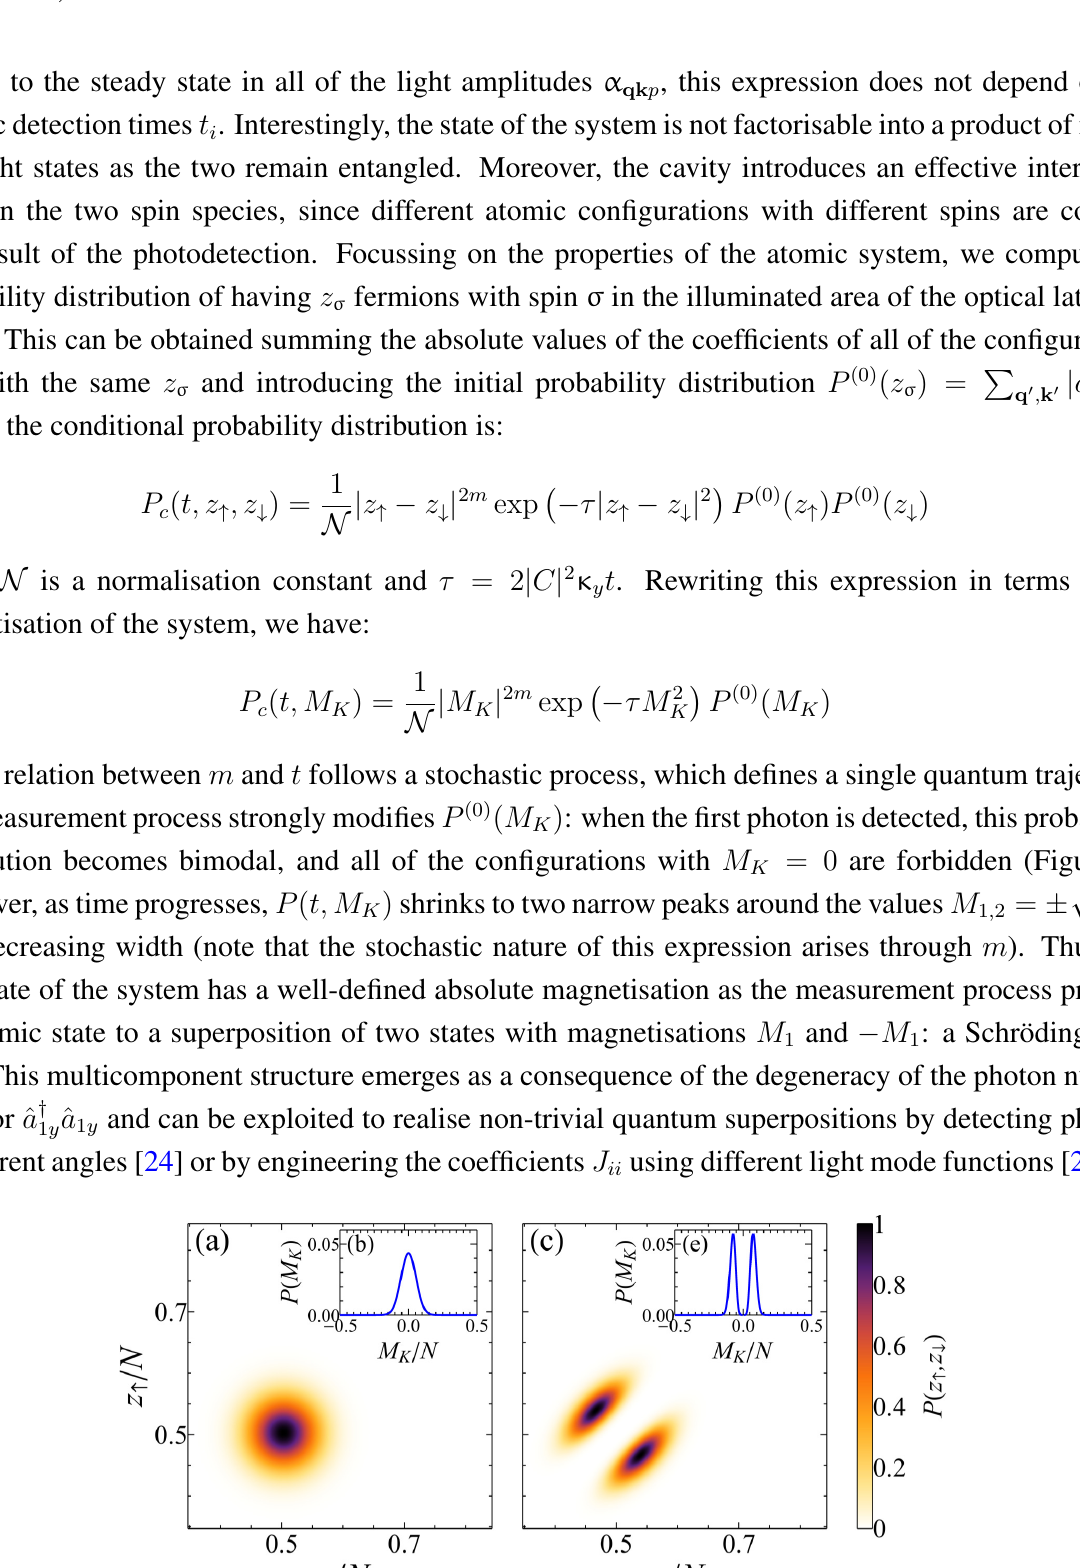
Figure 3. Probability distribution P ( z ( c ) for a fermionic system. The insets show the probability distribution of the magnetization P ( M ) for the initial state ( b ) and after photons are detected ( e ). Measurement backaction K creates a Schrödinger cat